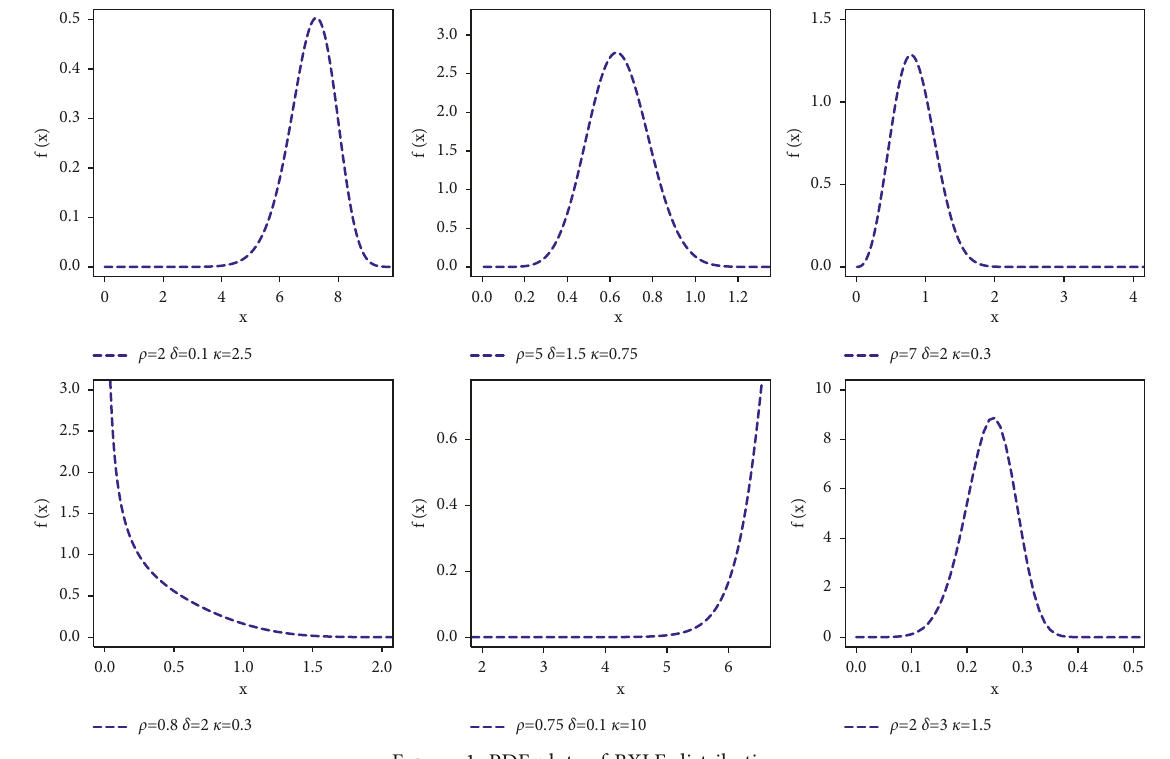
Figure 1: PDF plots of BXLE